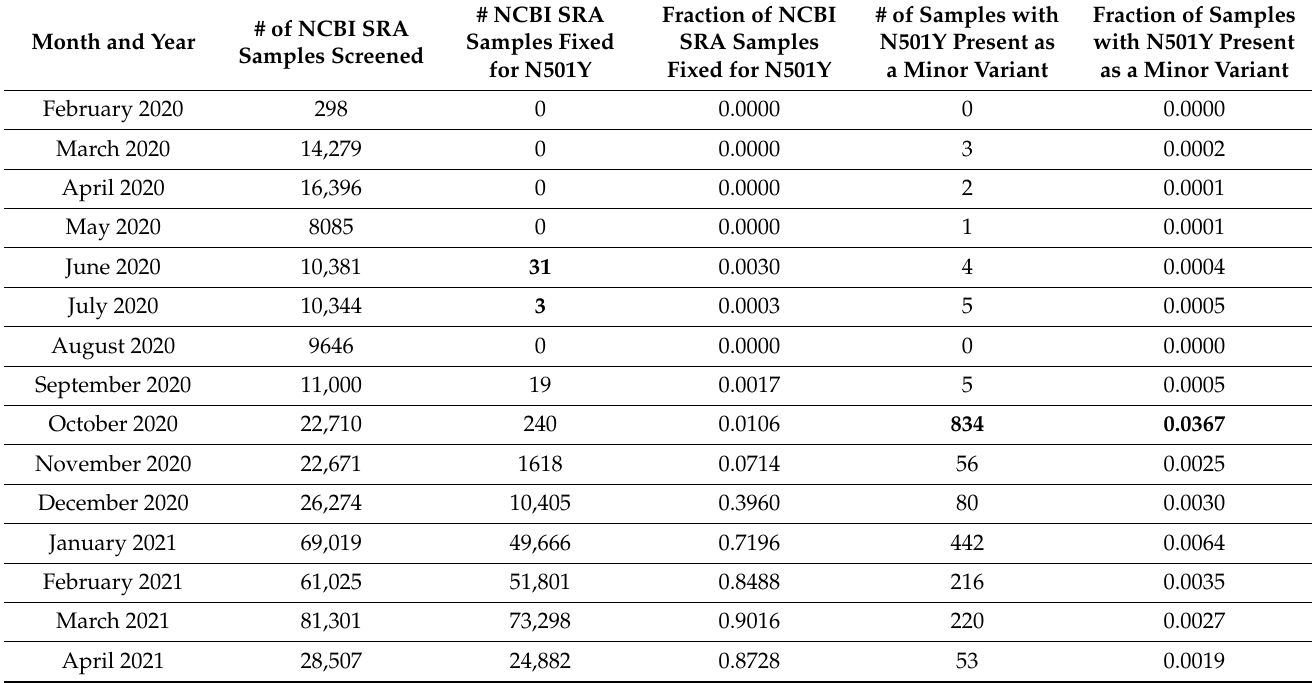
Table 1. Number of samples containing the Spike N501Y change present as a fixed variant or minor variant in NCBI SRA samples across each month as identified by iSKIM. Numbers in bold represent months where a high frequency of samples with the N501Y change was identified prior to emergence first in the Alpha VoC.